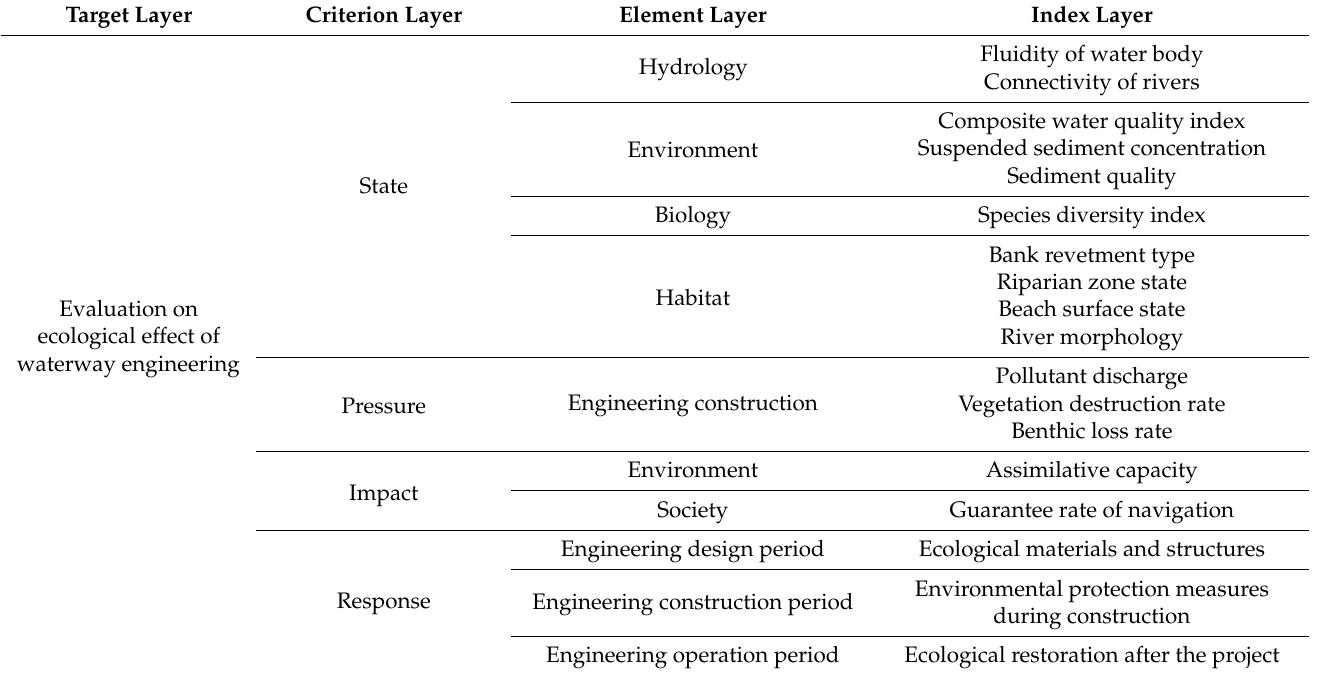
Table 1. Evaluation index system of ecological effect of waterway engineering based on SPIR conceptual